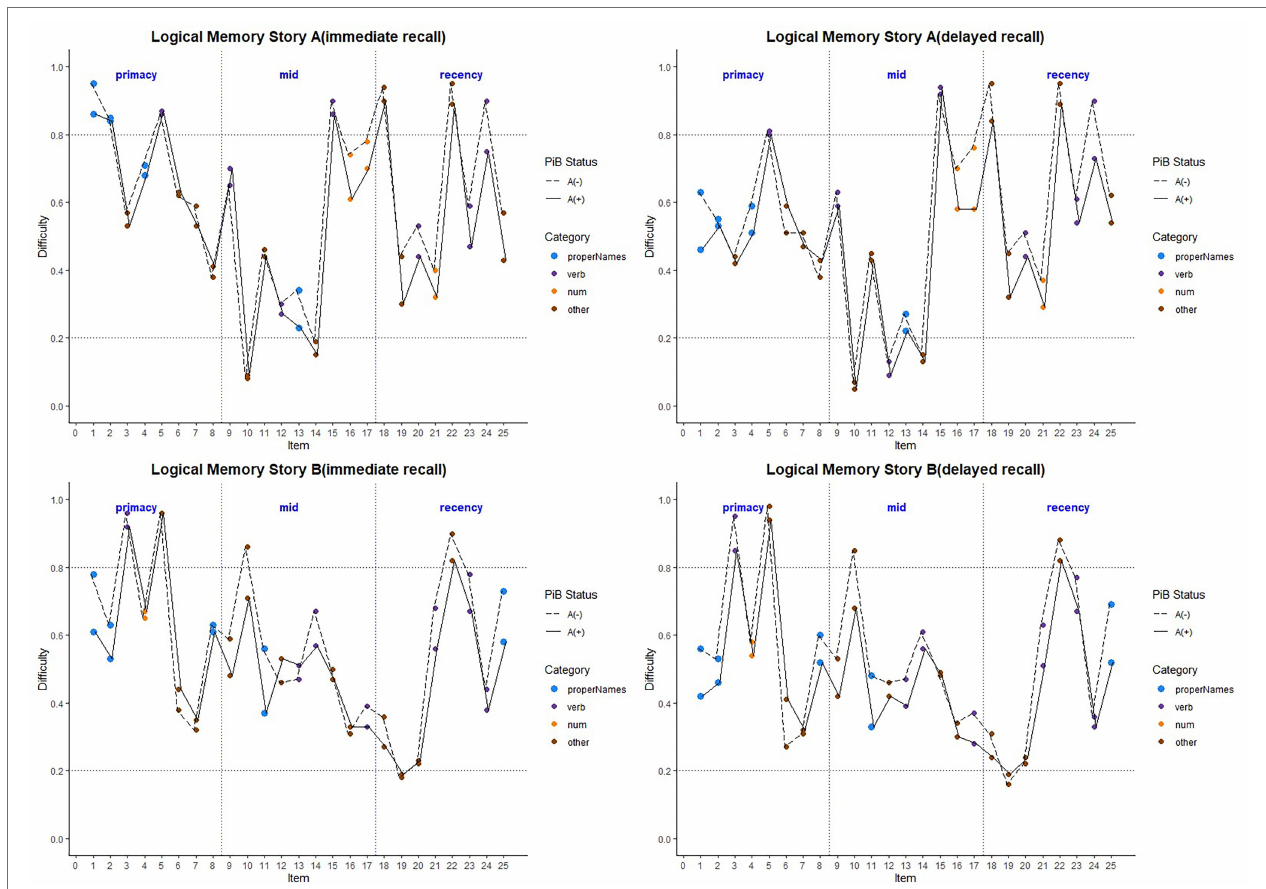
FIGURE 6 | Item difficulty plots by amyloid status according to the serial position (primacy, mid, and recency) as well as the lexical category of the items, by story A and story B. The colored circles indicate lexical categories, vertical dotted lines delineate serial position subgroups, and line types are A β + and A β− groups. The horizontal dashed lines are desirable difficulty values (between 0.2 and 0.8). Overall, the mean(SD) immediate recall difficulty was 0.540(0.22) for the A β + group compared with 0.594(0.23) in the A β− group ( w = 1425.5; p = 0.24; Cliff’s delta = 0.14). The mean(SD) delayed recall difficulty was 0.485(0.21) for the A β + group compared with 0.545(0.24) in the A β− group ( w = 1466.5; p = 0.14; Cliff’s delta =